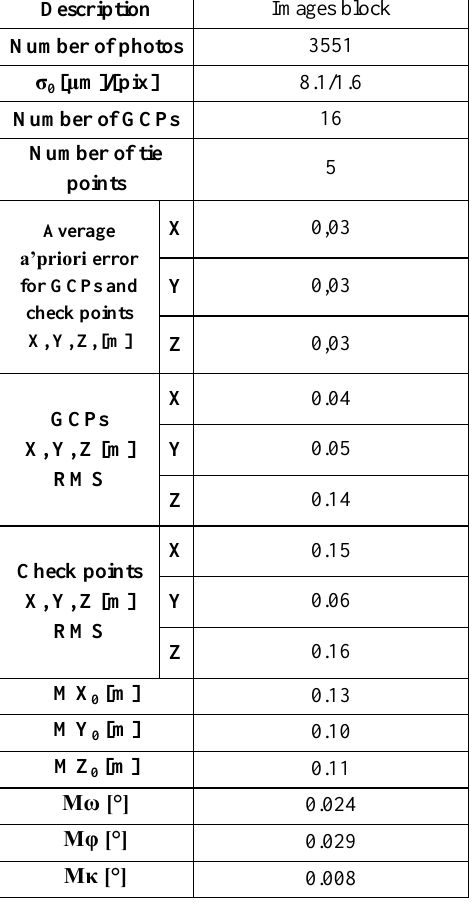
Table 1. Bundle Block Adjustment -